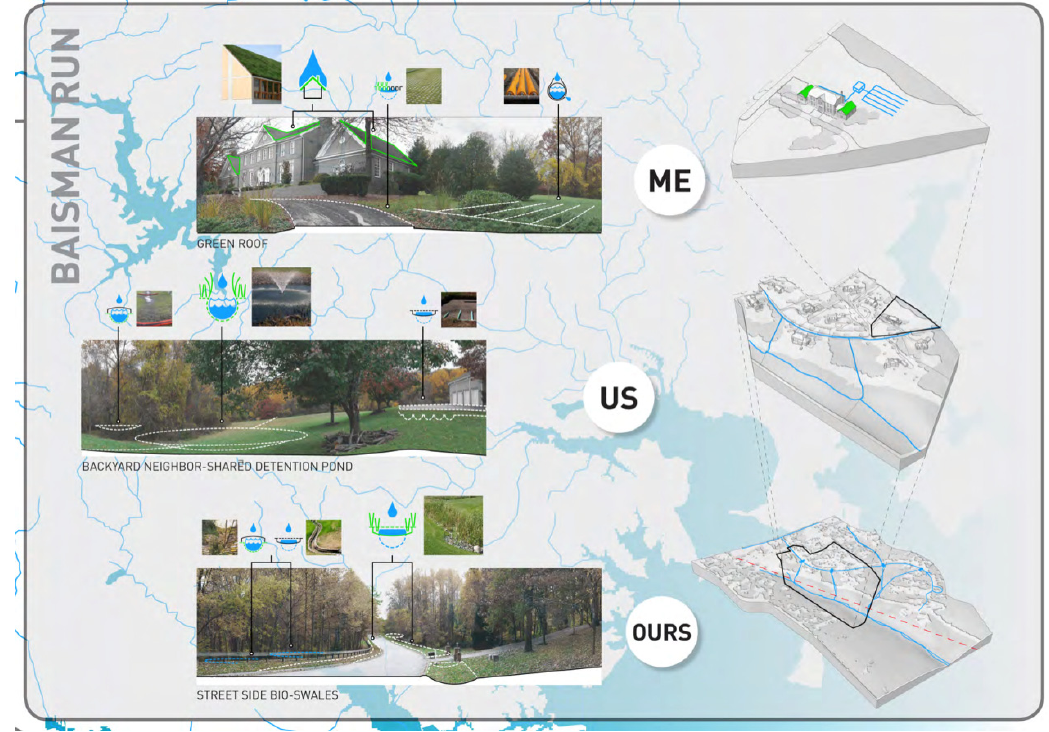
Figure 11. The final design scenarios for Baisman Run offer neighborhood residents the opportunity to choose not only the type of vegetation and water management they prefer, but also the scale in which they would like to act: as an individual property owner, in cooperation with their immediate neighbors, or through change in the municipal infrastructure. (Courtesy of